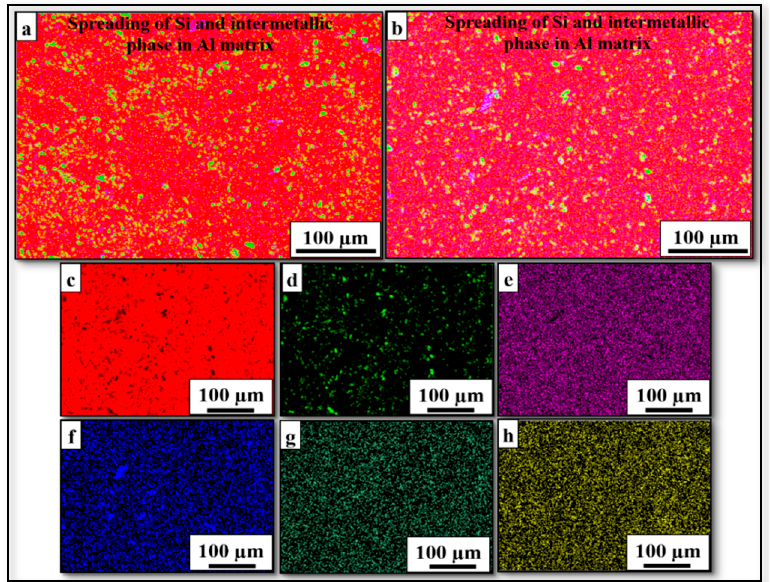
Figure 6. Mapping of the HPTed heat-treated as-cast A356 Al alloy ( a ) at the centre and ( b ) at the edge and alloying elements at the edge ( c ) Al, ( d ) Si, ( e ) Mg, ( f ) Fe, ( g ) Ti and ( h ) Cu, after 5 turns.